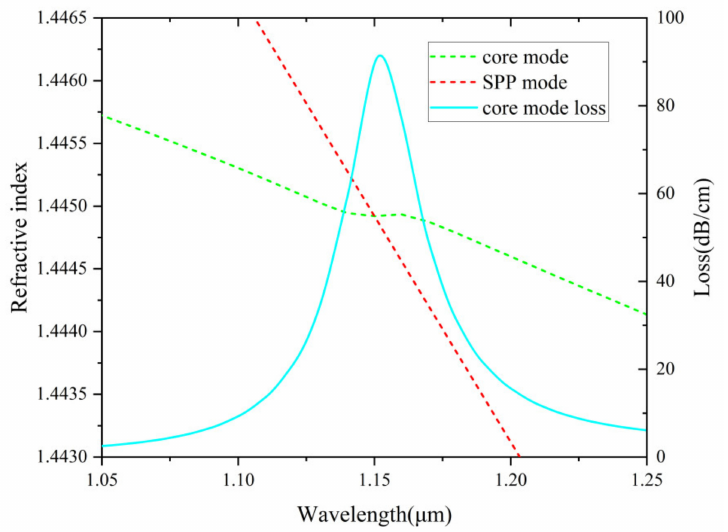
Figure 3. The change of loss spectrum and refractive index of the two modes (core and SPP) at n a =1.45 as a function of